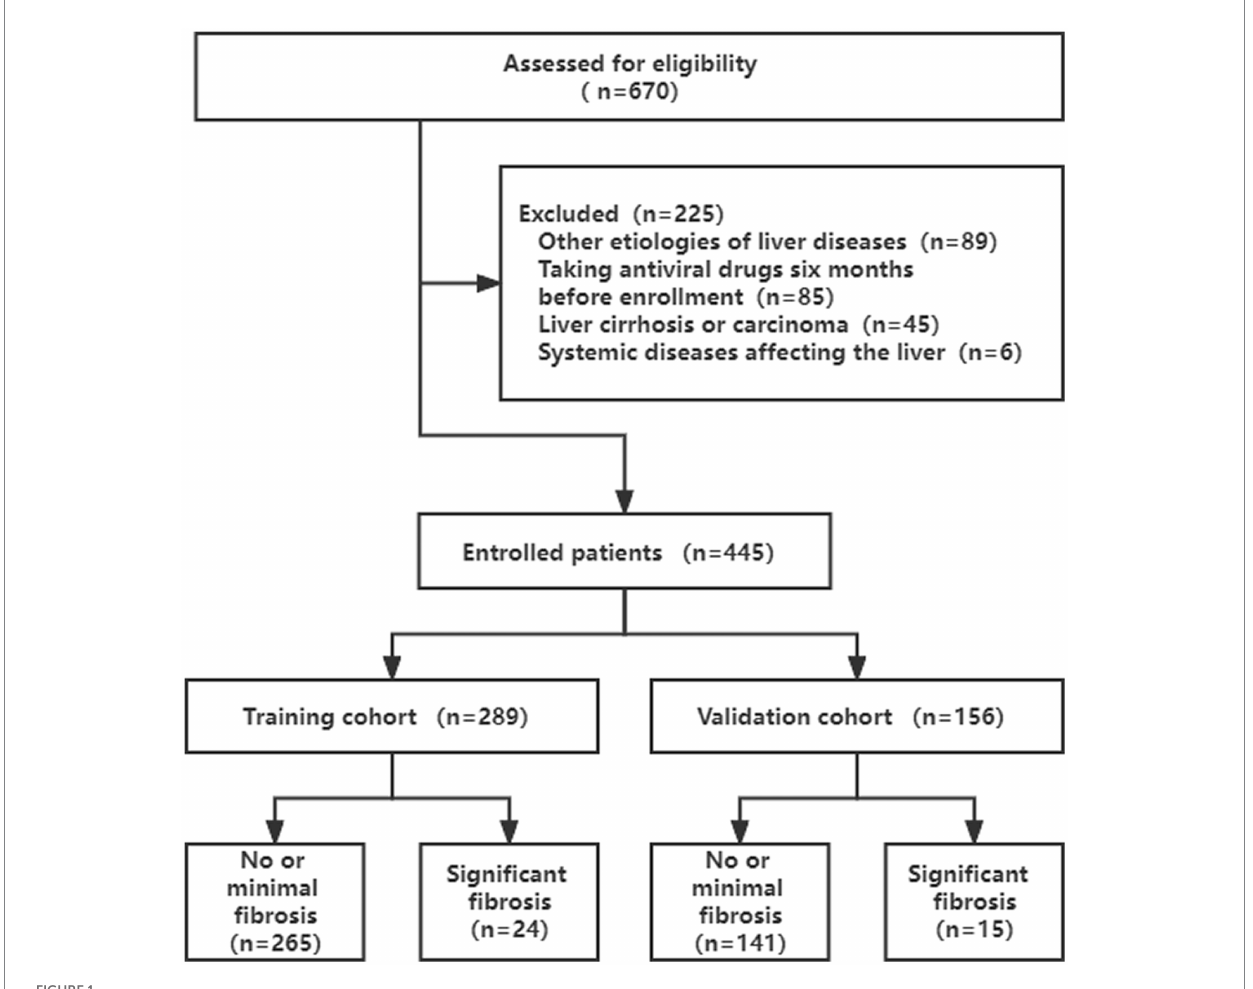
FIGURE 1 Flow chart presenting the study